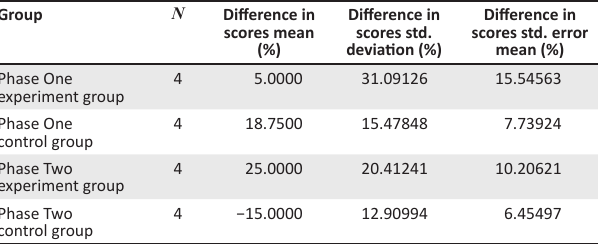
Difference in Difference in scores mean scores std. scores std. error (%) deviation (%) mean (%)